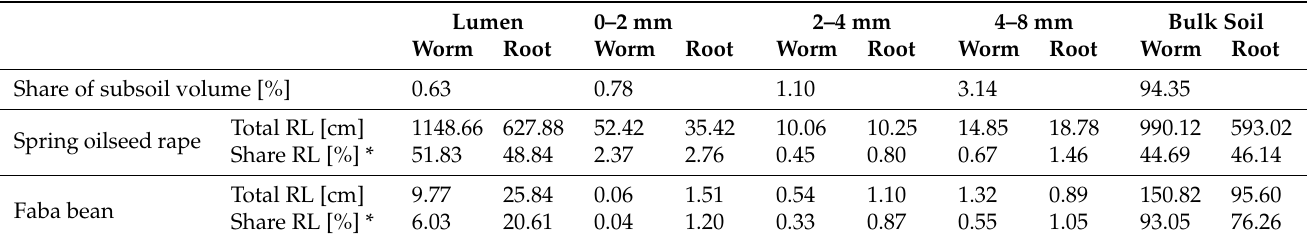
Table 3. Estimation of the soil area and the root distribution of spring oilseed rape and faba bean in worm or root type treatment. The mean root length (RL) in the biopore lumen, biopore sheath (0–2, 2–4, 4–8 mm) and bulk soil (20–36 mm) was estimated in 0.003 m 3 subsoil per column; Average biopore diameter of the sampled biopores under study: 8 mm, and sampling depth: 15–55